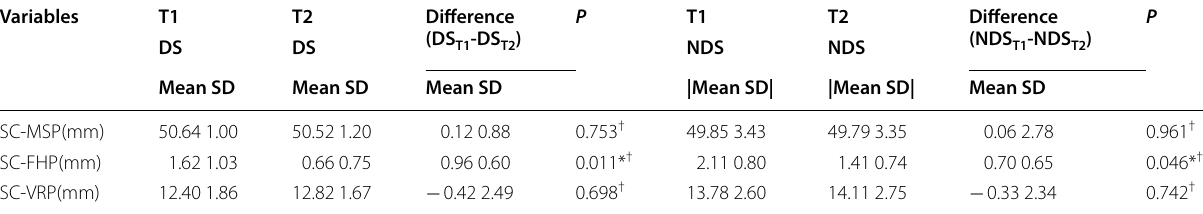
Table 5 Comparison of condylar position between deviated and non-deviated sides at T1 and T2, respectively (mandibular registration)